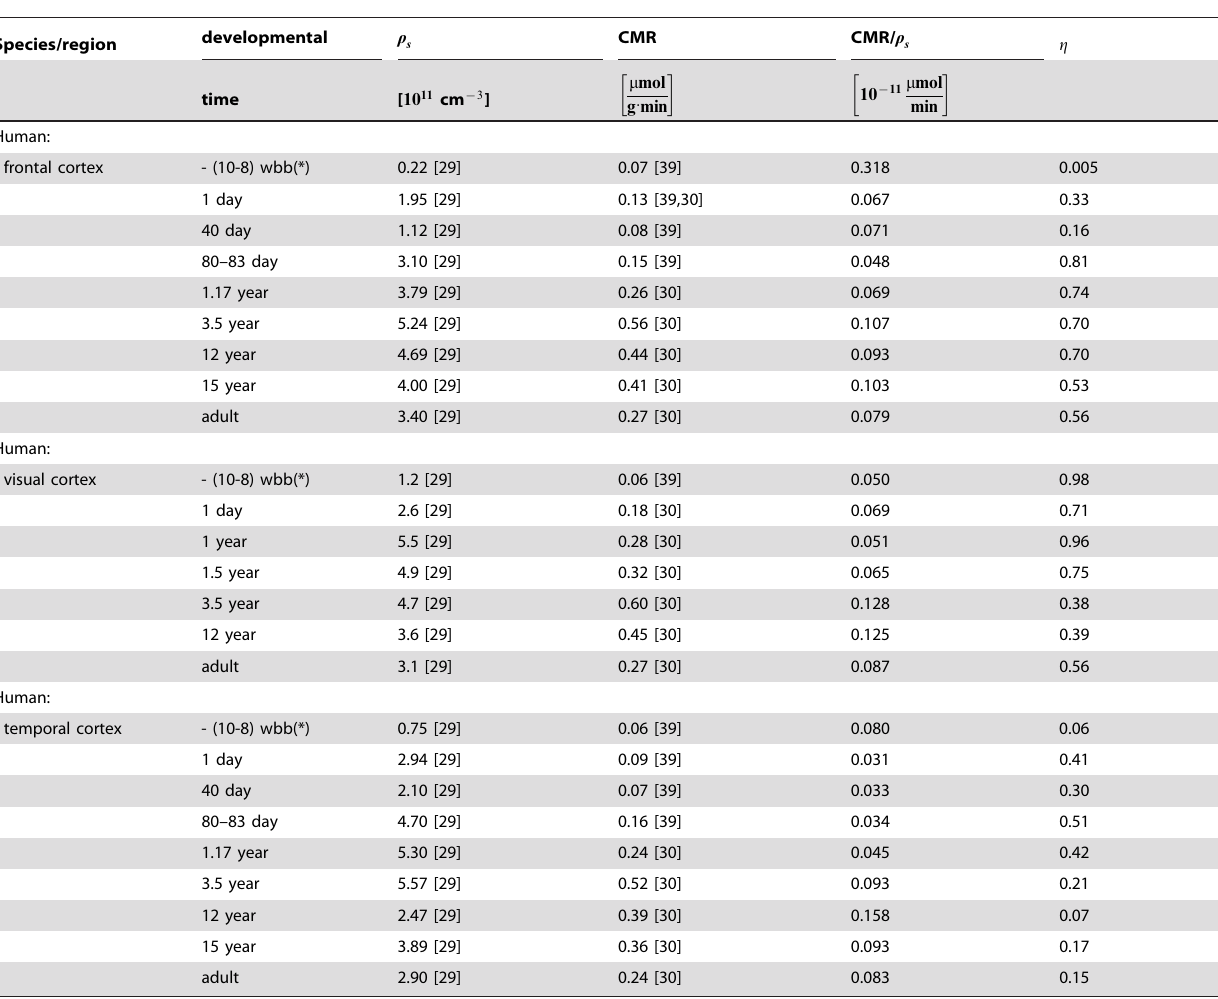
Table 3. Synaptic and metabolic development for human cerebral cortex.